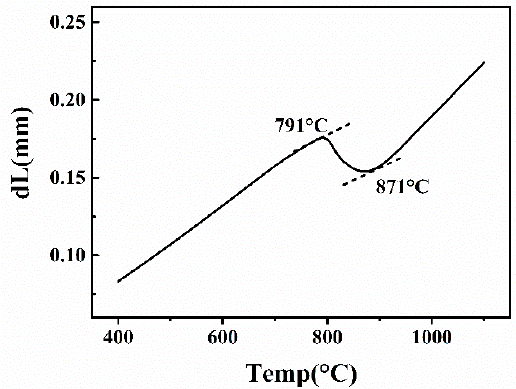
Figure 2. Thermal expansion curve of as-welded specimen.